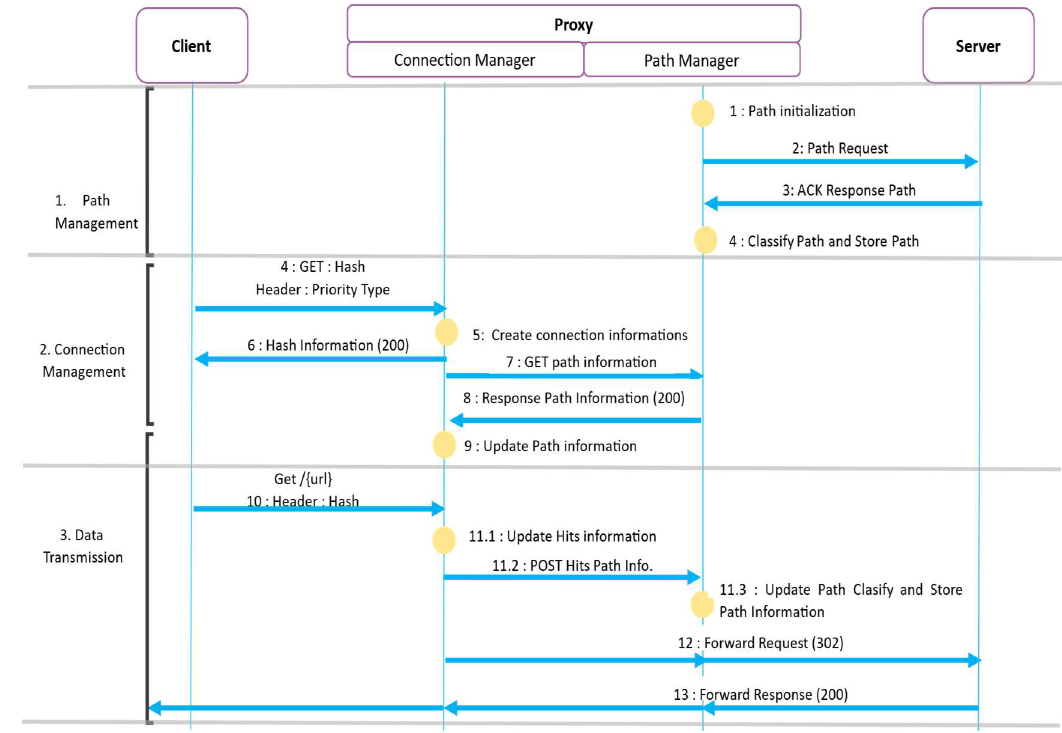
Figure 2. The overall operation of the proposed MP-QUIC